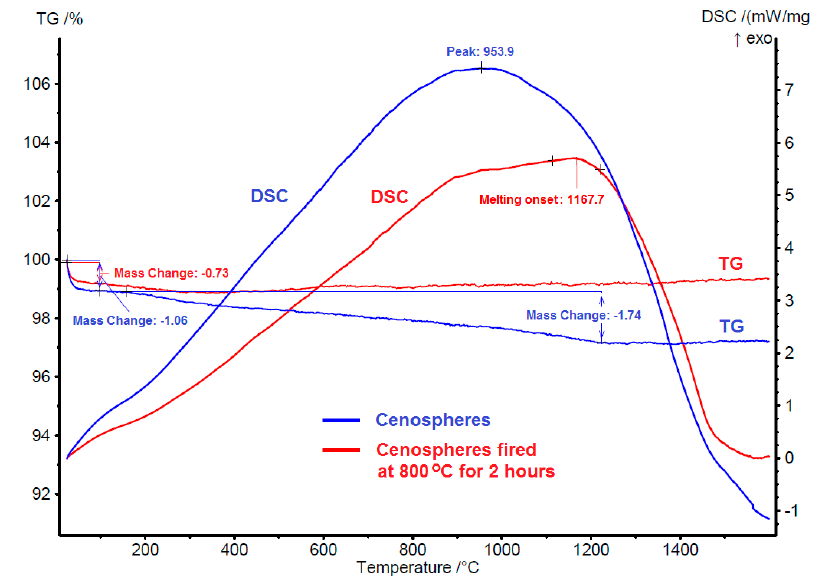
Figure 1. TG and DSC curves of cenospheres and fired cenospheres (800 °C for 2 h) samples.